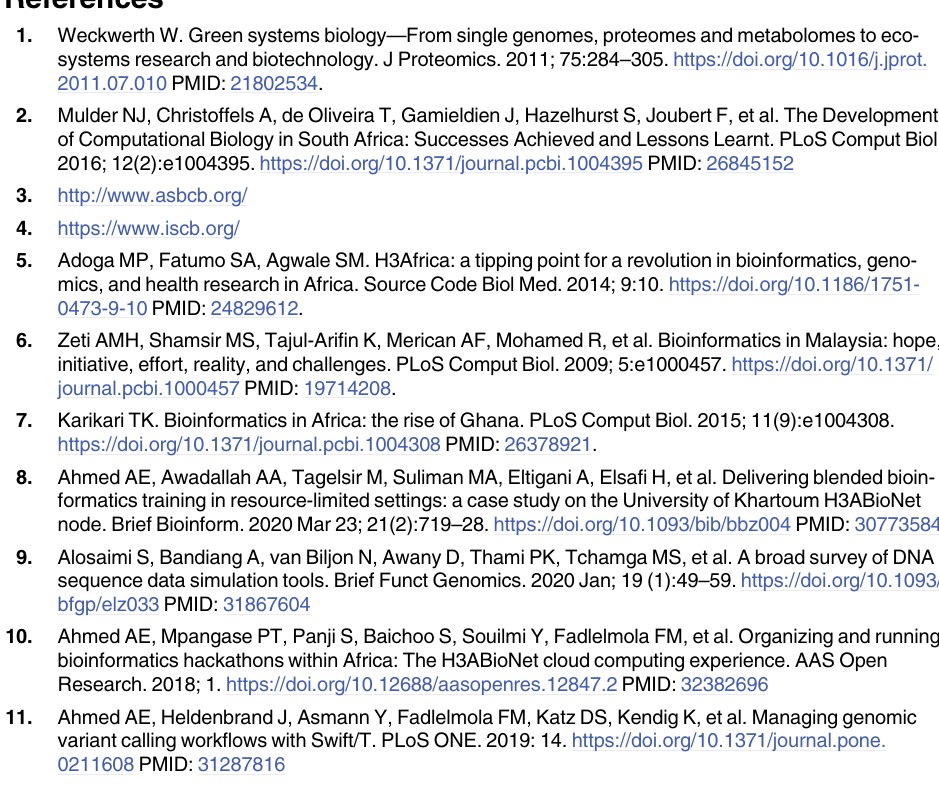
S1 Table. Bioinformatics-related publications in Sudan from 2003 to 2020. The table indi- cates the outcome of all the retrieved bioinformatics-related publications authored by Suda- nese researchers from 2003 to 2020. The DOI of the comprehensive protocol used in this publication is